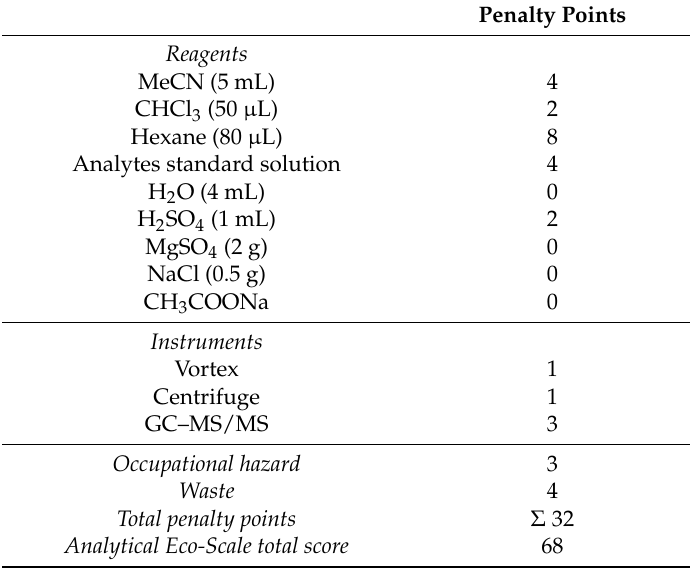
Table 8. Analytical Eco-Scale assessment of the proposed method according to Galuszka et al.